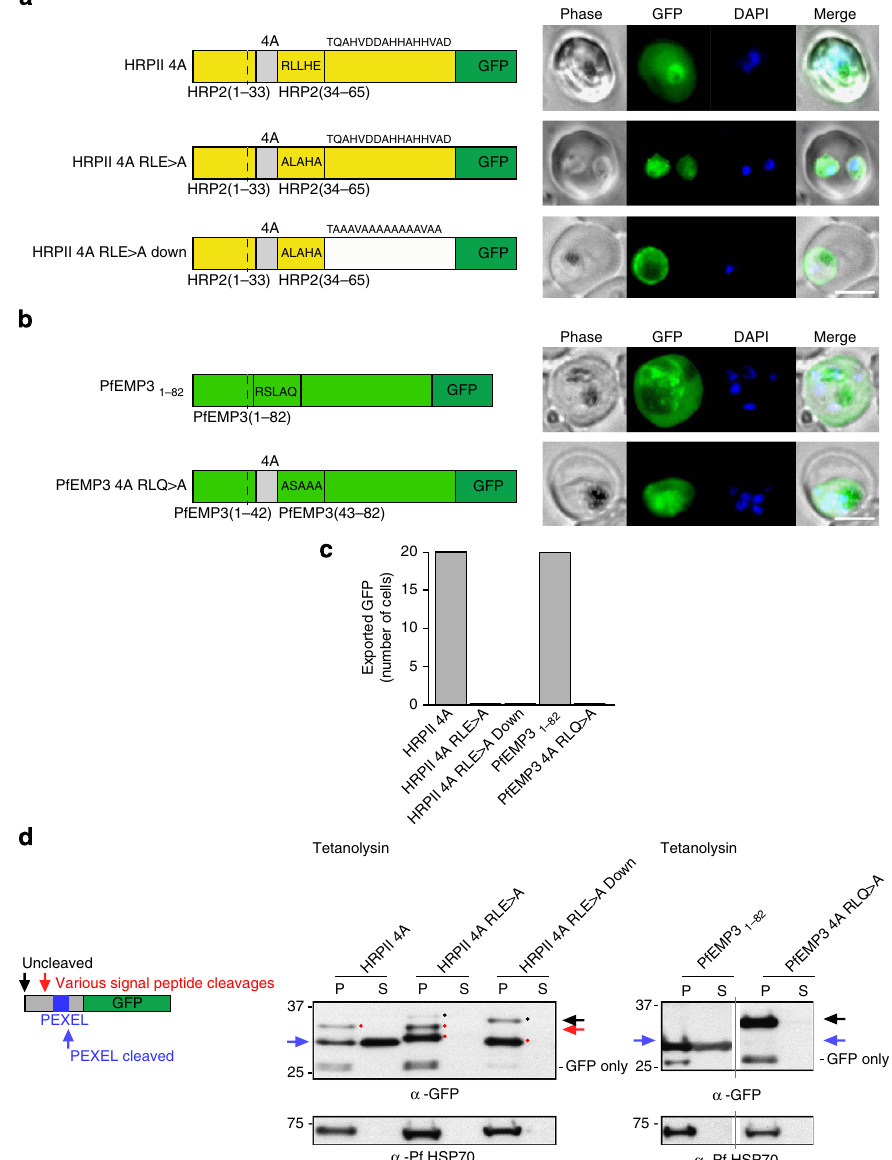
Figure 4 | PEXEL-independent export of PEXEL proteins does not occur in P. falciparum . ( a ) HRPII 4A is exported to the P. falciparum- infected erythrocyte. HRPII 4A RLE 4 A and HRPII 4A RLE 4 A Down are not exported. Scale bar, 5 m m. ( b ) PfEMP3 1–82 is exported by P. falciparum to the erythrocyte, but PfEMP3 4A RLQ 4 A is not. Scale bar, 5 m m. ( c ) Quantification of cells with exported GFP determined using 20 P. falciparum -infected erythrocytes per construct (10 cells per experiment, performed twice). ( d ) Immunoblot with anti-GFP antibodies of chimeras from the tetanolysin pellet (P) and supernatant (S) shows that HRPII 4A and PfEMP3 1–82 are cleaved at the PEXEL (blue arrow) and exported. Signal peptide-cleaved HRPII 4A was also visible (red spot). HRPII 4A RLE 4 A, HRPII 4A RLE 4 A Down and PfEMP3 1–82 RLQ 4 A were not exported and bands corresponding to signal peptide-cleaved (various positions possibly due to insertion of four alanines; red spots/arrow) and uncleaved protein (black spots/arrow) are present. Full-length gels shown in Supplementary Fig.